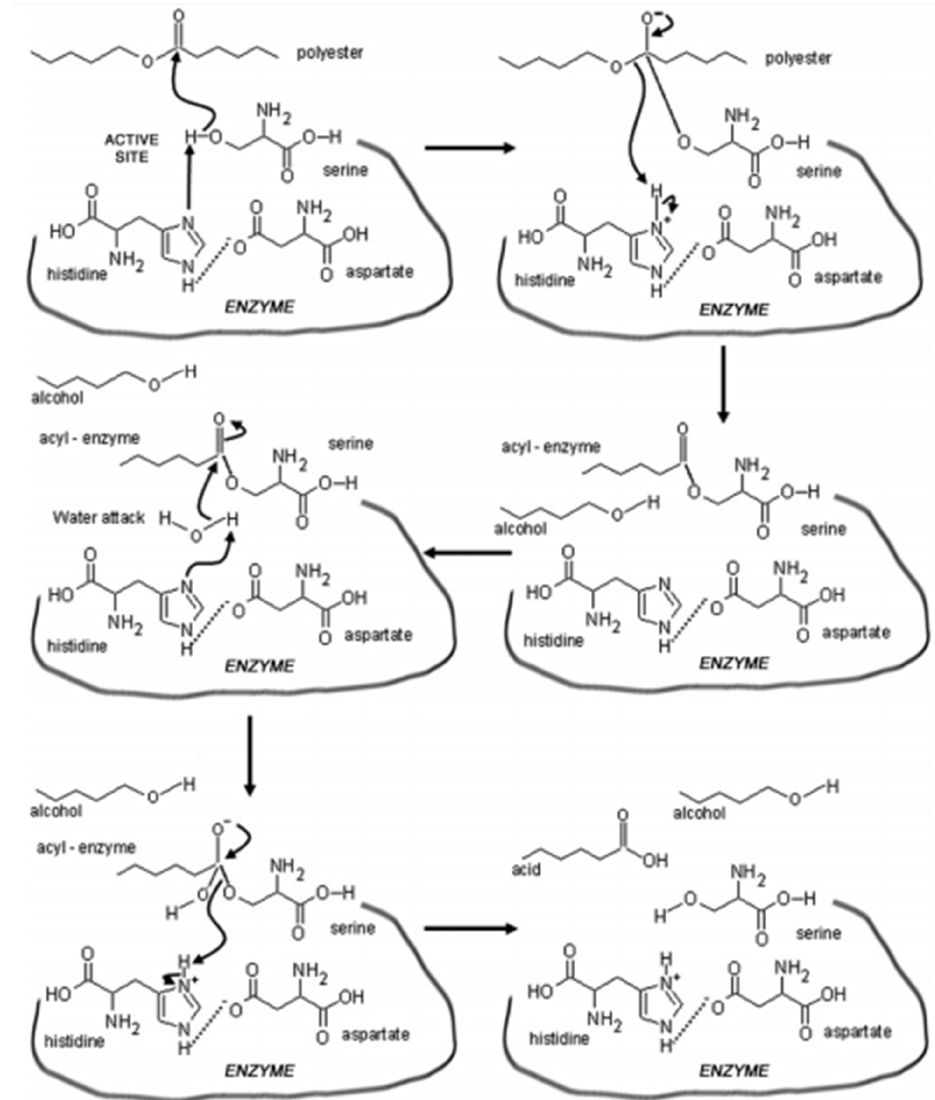
Figure 1. Enzymatic hydrolysis of polymers and catalytic site of depolymerase enzymes [13].